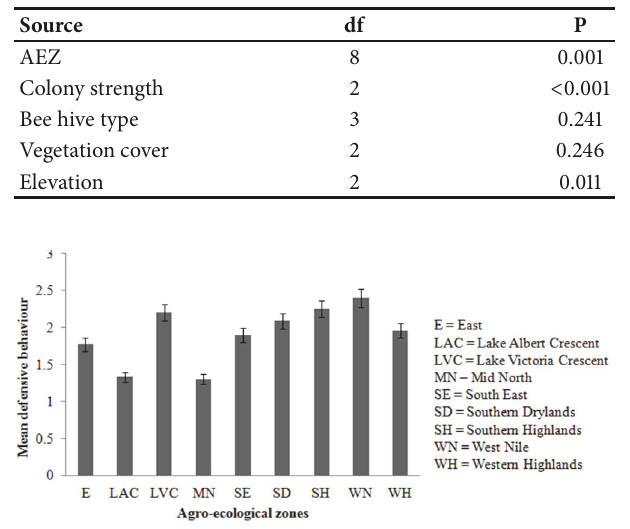
Figure 2: Comparison of the defensive behaviour of the honeybees in the AEZs of Uganda. The defensive behaviour was scored as 1 = very defensive; 2 = moderate; and 3 = less defensive.